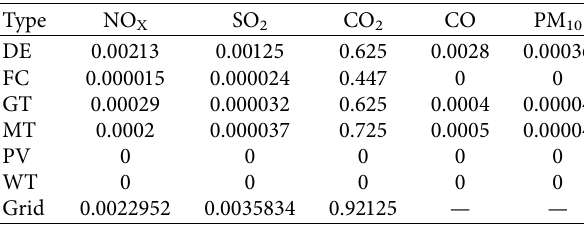
Table 5: Specification of substations.